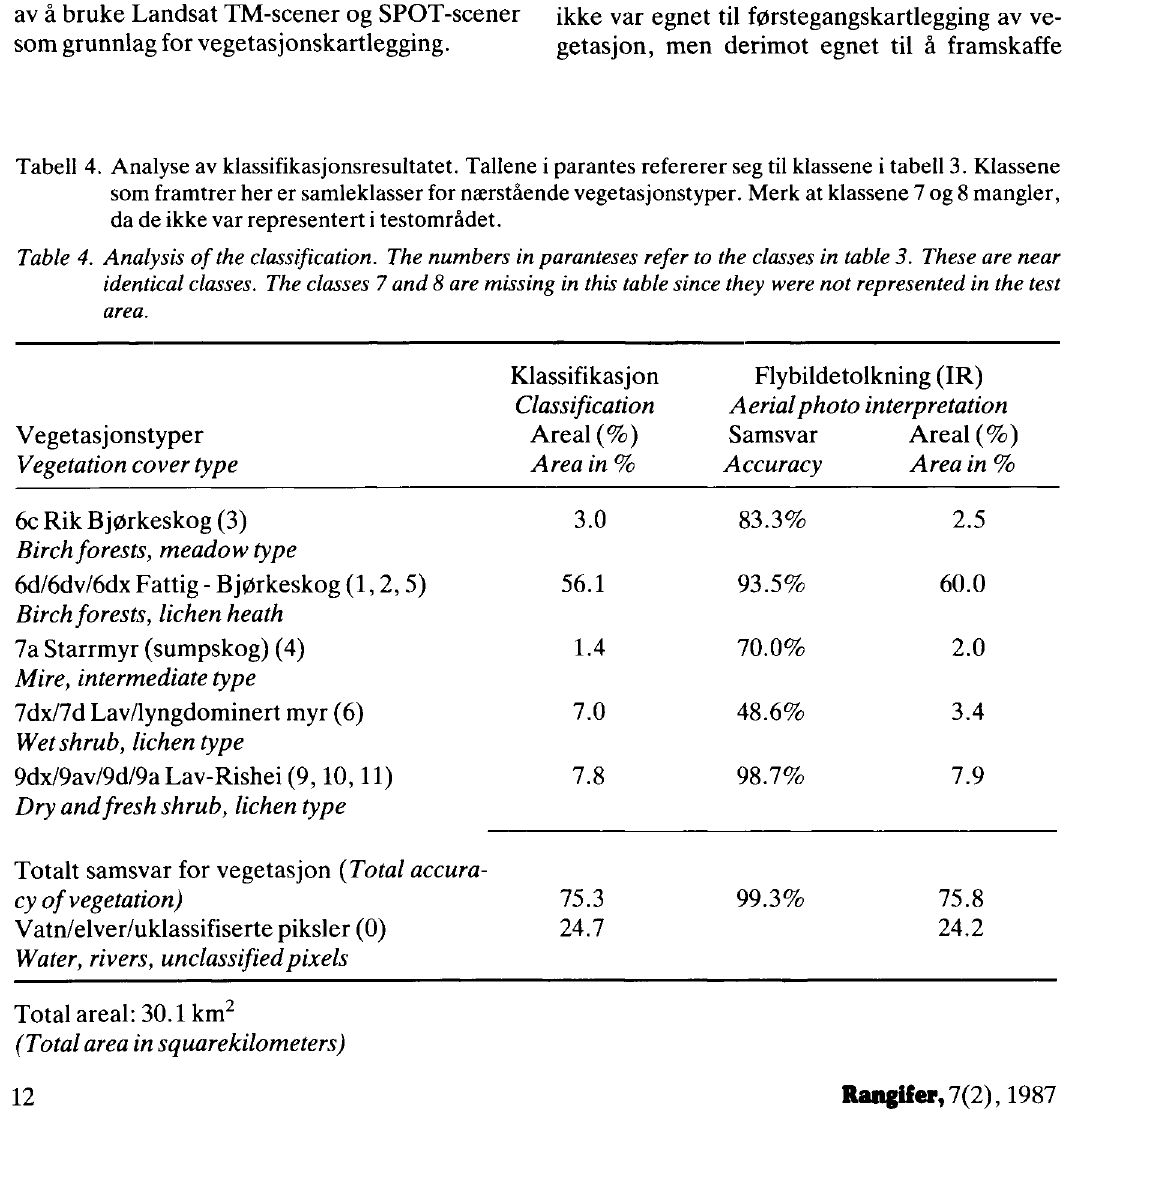
Table 4. Analysis of the classification. The numbers in paranteses refer to the classes in table 3. These are near identical classes. The classes 7 and 8 are missing in this table since they were not represented in the test